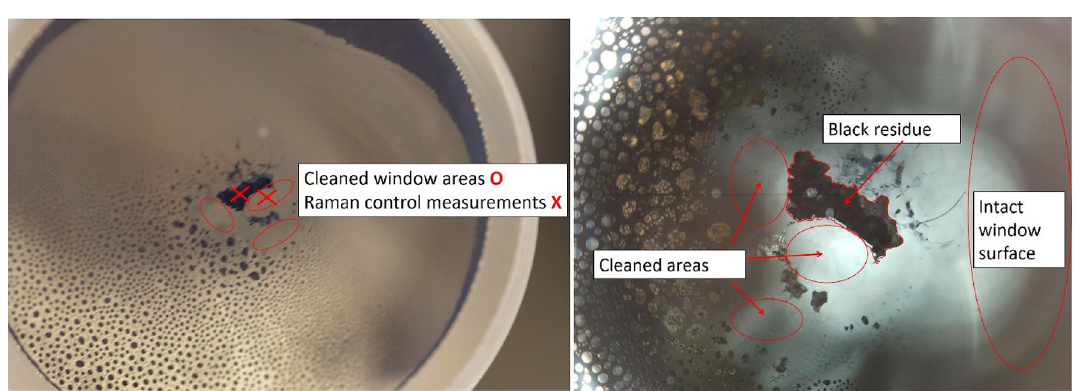
Figure 6. Rubidium cell window after laser cleaning; a small part of the black deposit is left for the purpose of control measurements. The Raman spectroscopy analysis was performed at the locations marked with